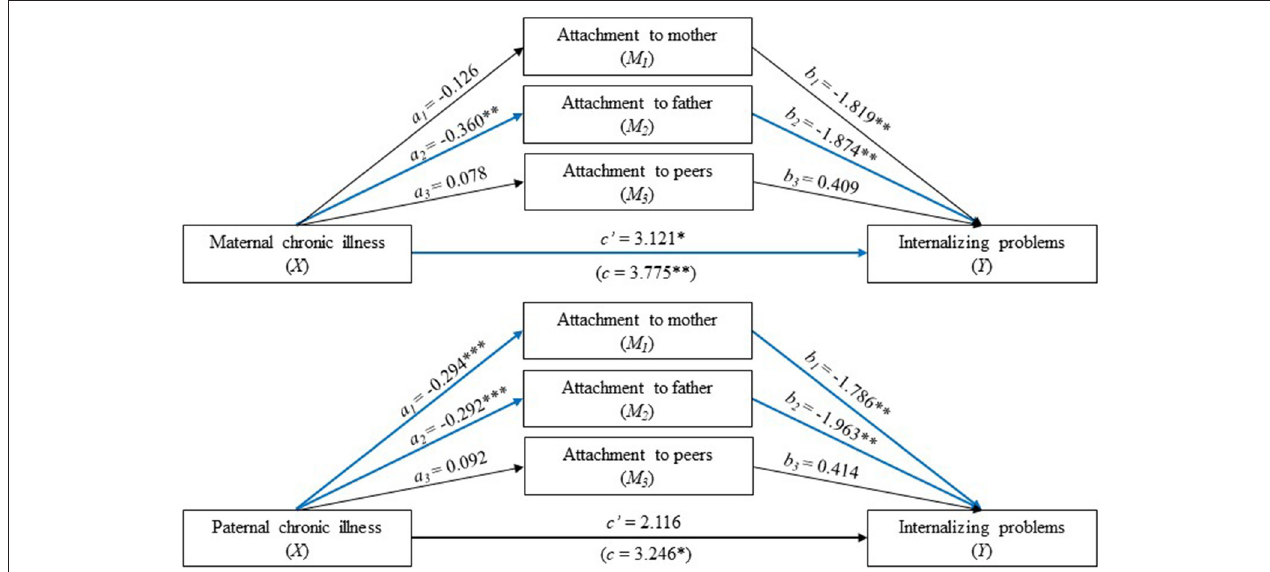
FIGURE 2 | Parallel mediation analysis with parental (maternal above and paternal below) chronic illness status (0 is no and 1 is yes) as the independent variable (X), internalizing problems in young adulthood with a high score indicates high levels of problems (Y), and attachment to the mother, father, and peers as the mediators (a high score indicates secure attachment). The values are unstandardized regression coefficients. a n is the effect of parental chronic illness in adolescence on attachment to the mother, father, and peers; b n is the effect of attachment to the mother, father, and peers on internalizing problems in young adulthood. The analysis was adjusted for adolescent sex and parental SES and divorce. The blue lines show a statistically significant path. * p < 0.05, ** p < 0.01, *** p <